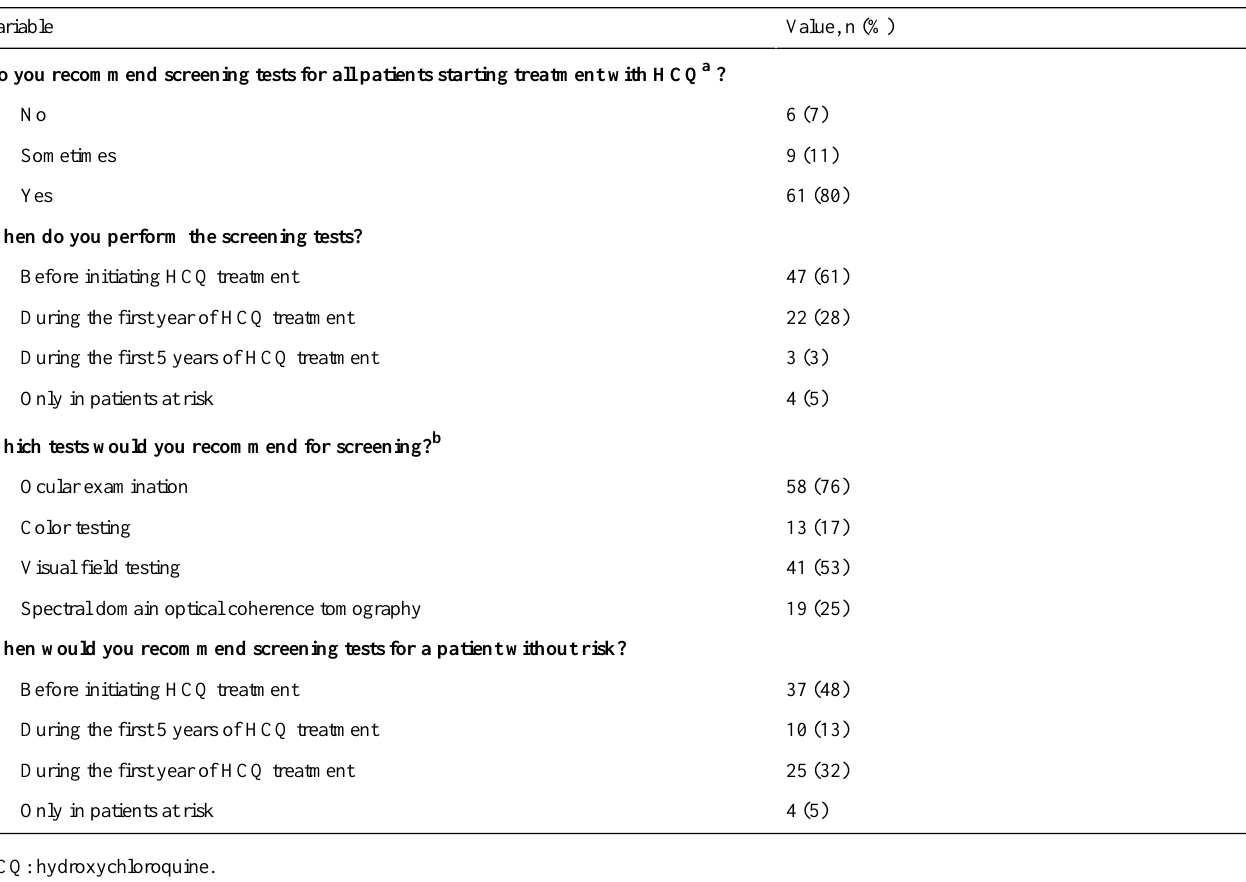
Table 3. Screening-related questions.